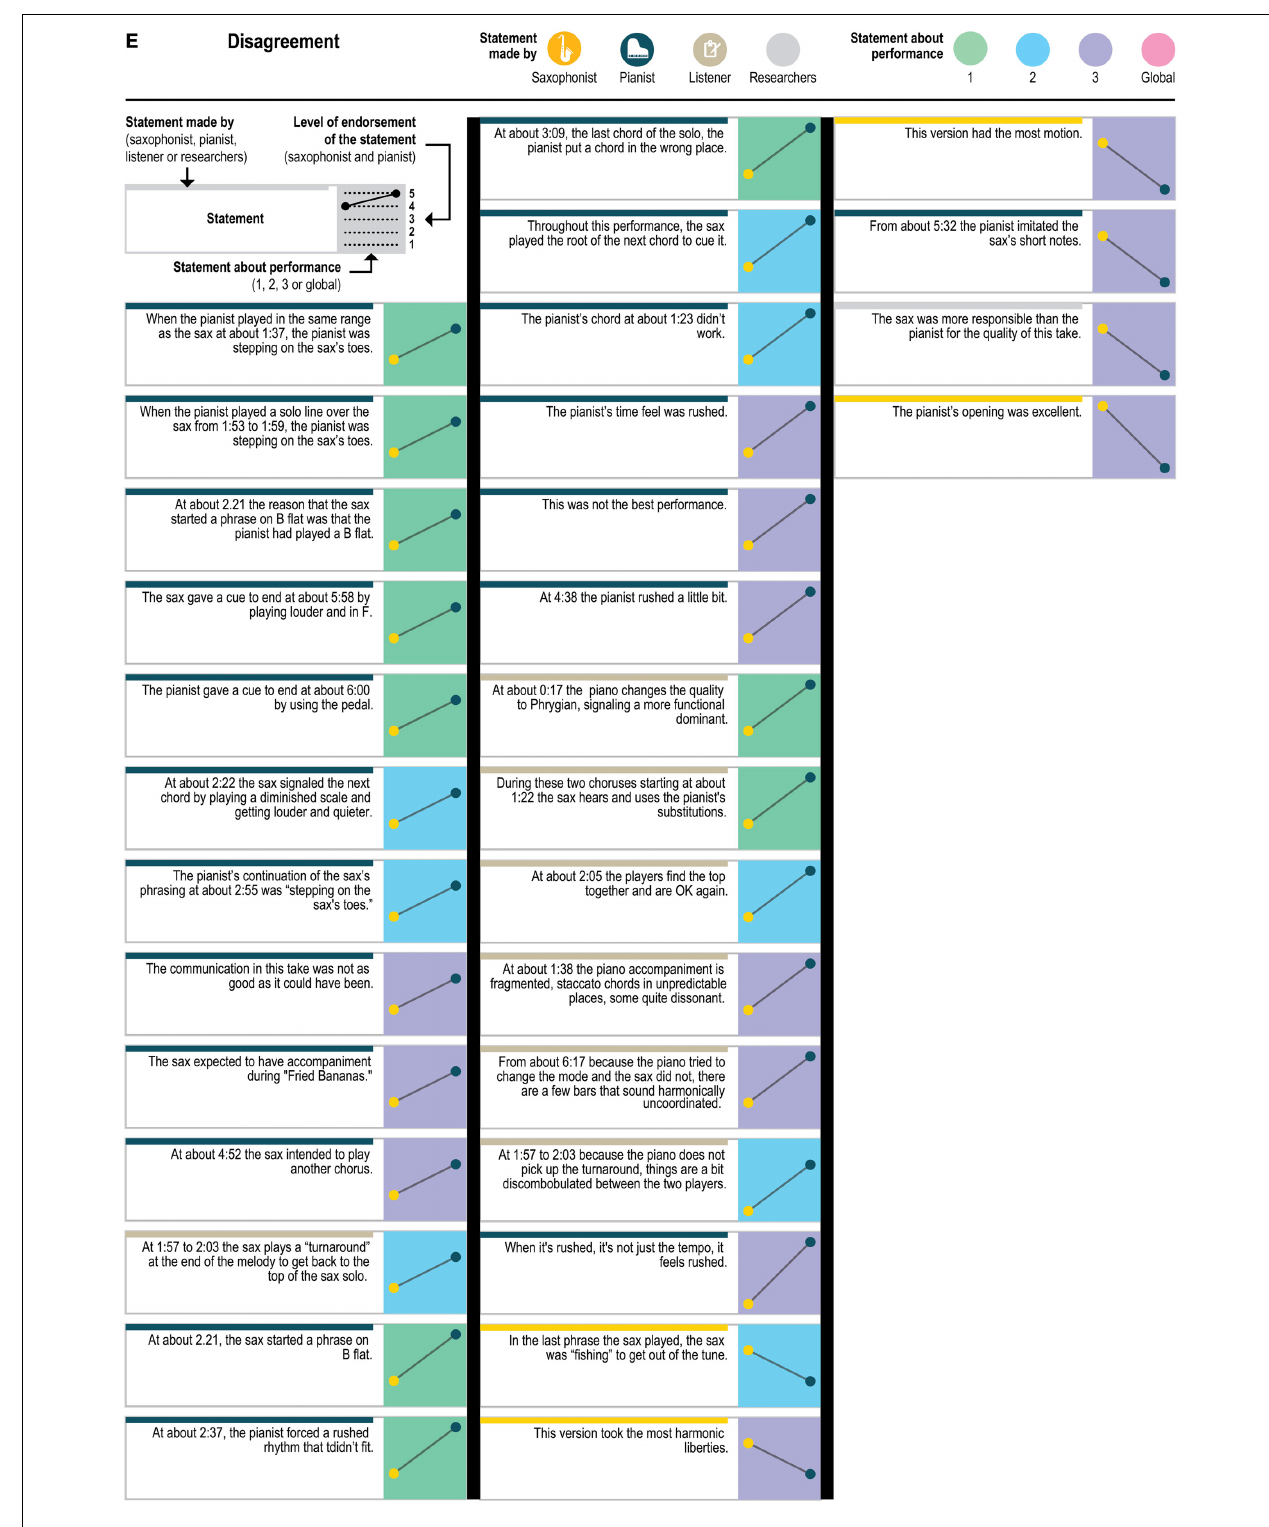
FIGURE 5E | Statements with disagreement (ratings differed by 3 or 4 rating points).